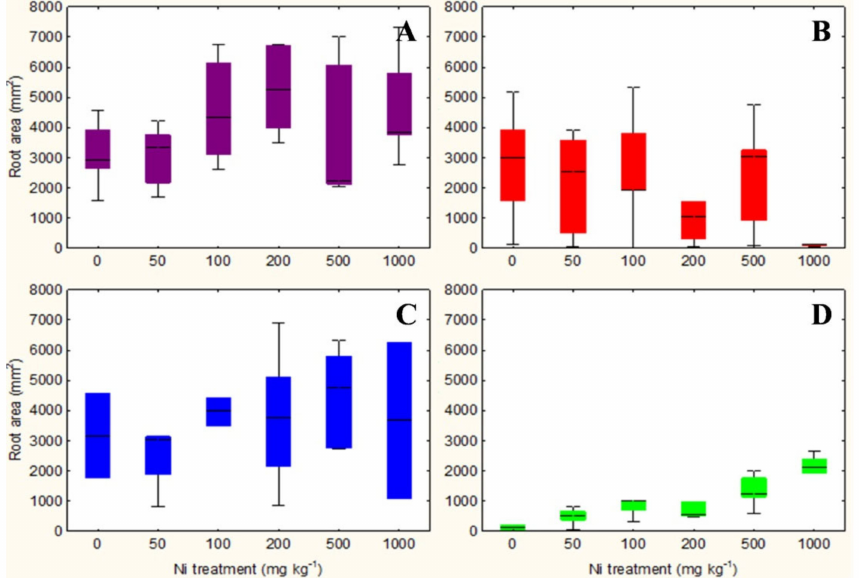
Figure 1. Box-and-whisker plots showing the root surface area (mm 2 ) of test hyperaccumulator species at increasing Ni concentrations (0–1000 mg kg − 1 ): ( A ) A. utriculata , ( B ) N. caerulescens and non-hyperaccumulator species ( C ) A. montanum , ( D ) T. arvense. In each box, the central line marks the median of the data; the box edges represent the first and third quartiles; whiskers show non-outlier range. n = 20 each treatment.